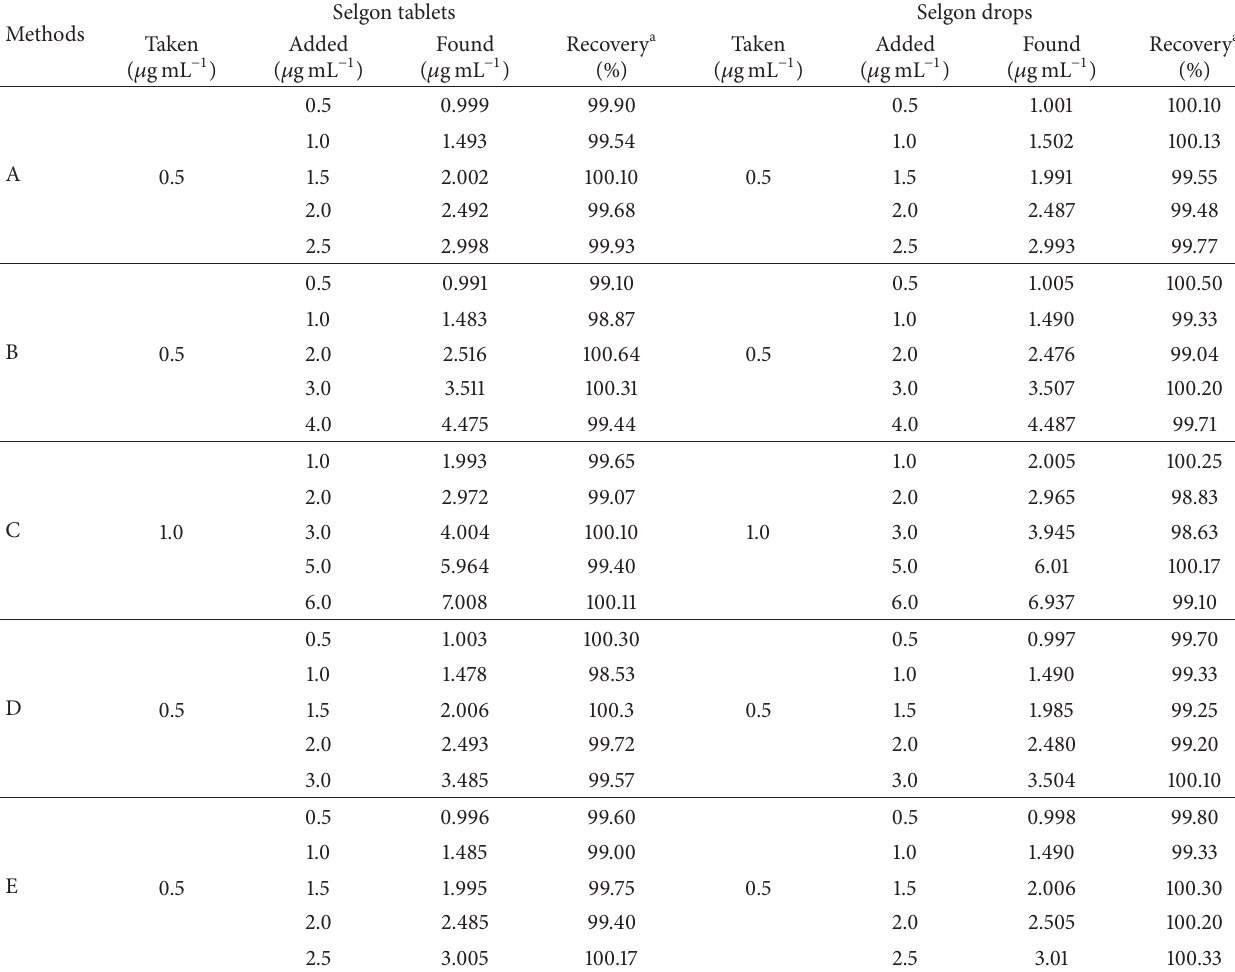
Table 4: Standard addition method for the determination of PZT in drug